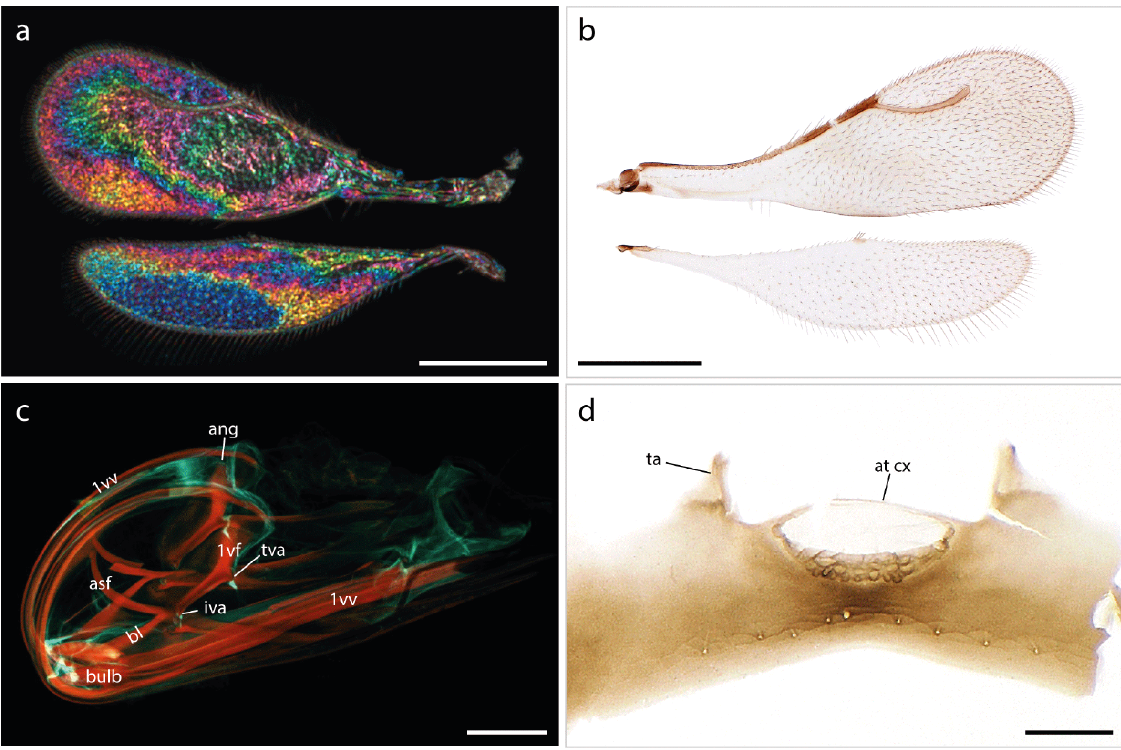
Fig. 2. Detailed images of A. kretschmanni Moser sp. nov. (a, d = SMNS_Hym_Cer_000466; b = SMNS_Hym_Cer_000465; c = SMNS_Hym_Cer_000469). a . Wing interference patterns of left fore- and hindwing. b . Fore- and hindwing. c . CLSM image of ovipositor with sclerites in red. Abbreviations: 1vf = 1 st valvifer; 1vv = 1 st valvulae; ang = anterior angle of the 1 st valvifer; asf = anterior section of the dorsal flange of the second valvifer; bl = basal line of the second valvifer; bulb = bulbous anterior area of the dorsal valve; iva = intervalvifer articulation; tva = tergo-valvifer articulation. d . Waterston’s evaporatorium on T6. Abbreviations: at cx = acrotergal calyx; ta = tergal apodeme. Scale bars: a–b = 200 µm; c–d = 50